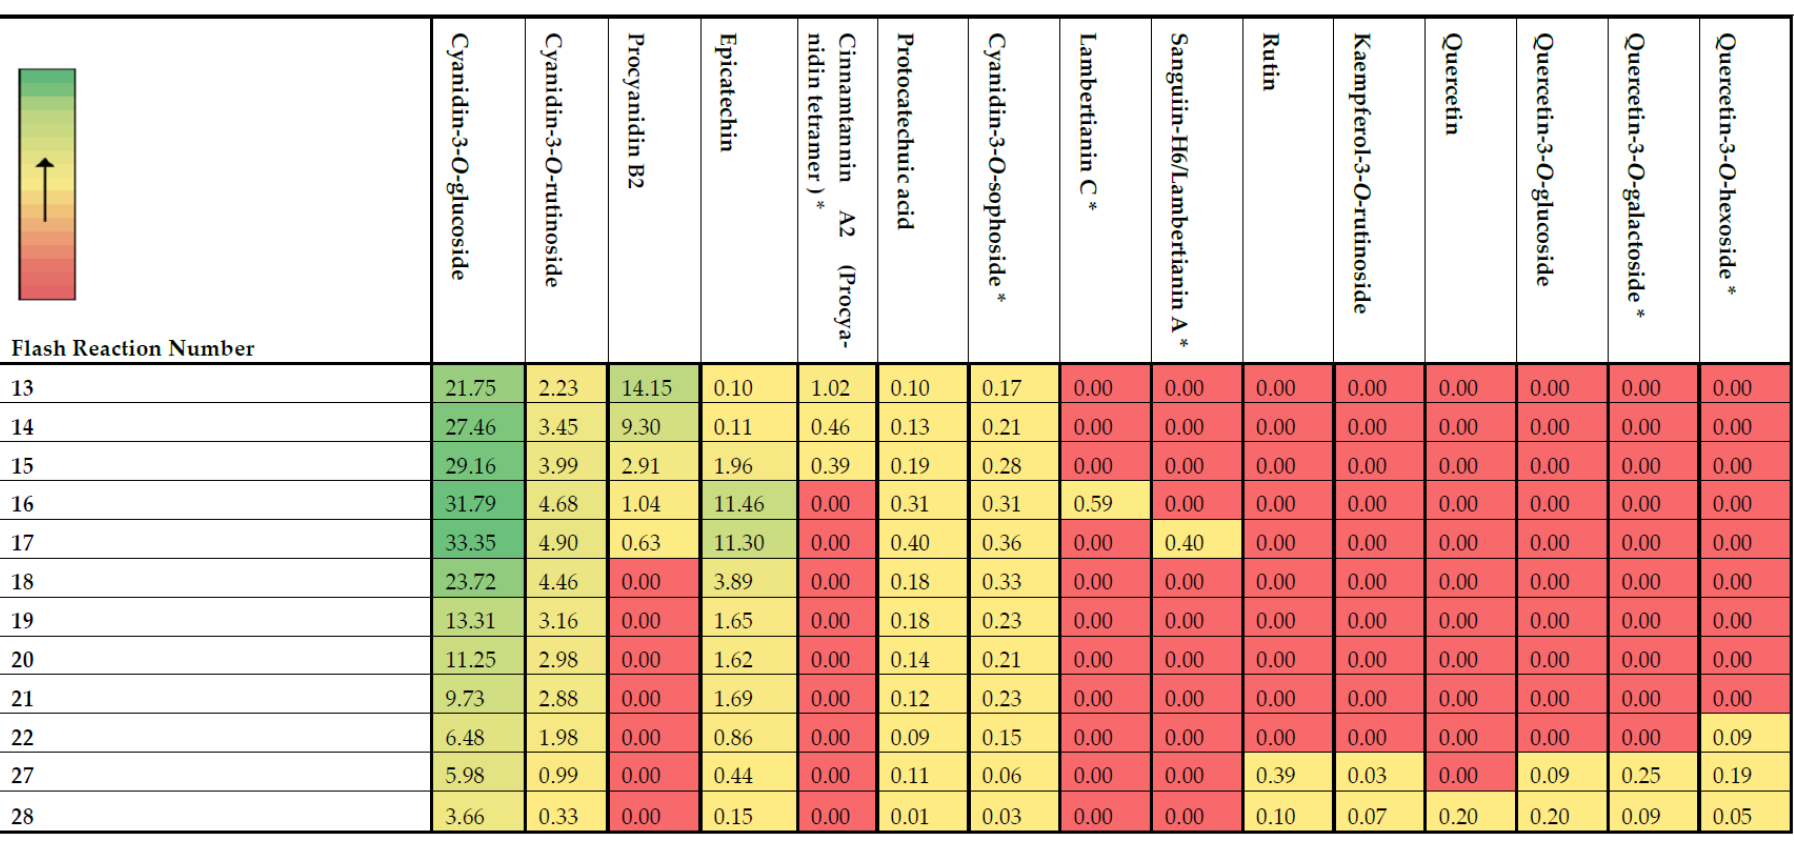
Figure 3. Heat map of the quantified major phenolic compounds in the most antioxidant-potent fractions through UPLC-TQD-MS/MS. Data are expressed as μg/mL.